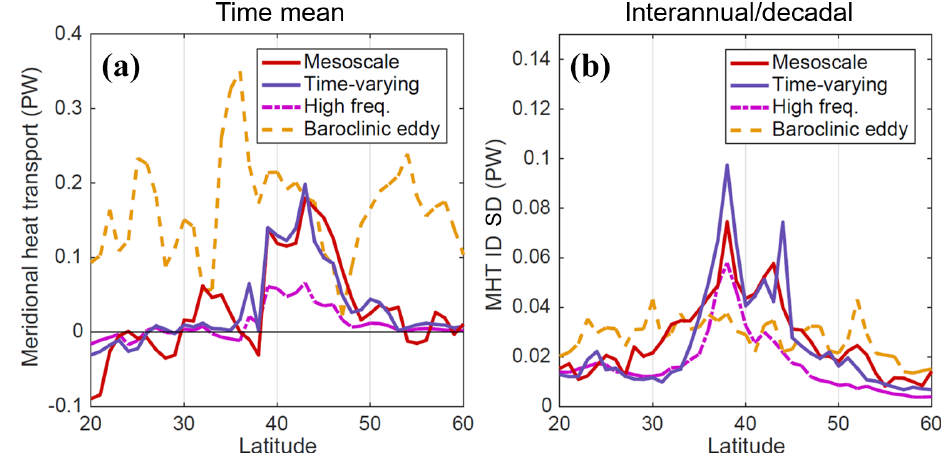
Figure 15. (a) POP time-mean contributions to meridional heat transport (MHT) in the North Atlantic from eddy formulations computed four ways: the mesoscale component computed as the bracketed portion of Eq. (3), the time-varying component v (cid:48) T (cid:48) (e.g., Jayne and Marotzke, 2002), the high-frequency component using only v (cid:48) and T (cid:48) on timescales shorter than 3 months (Volkov et al., 2008), and the baroclinic eddy component as defined in Hall and Bryden (1982). (b) MHT standard deviation (on ID timescales) of the four eddy